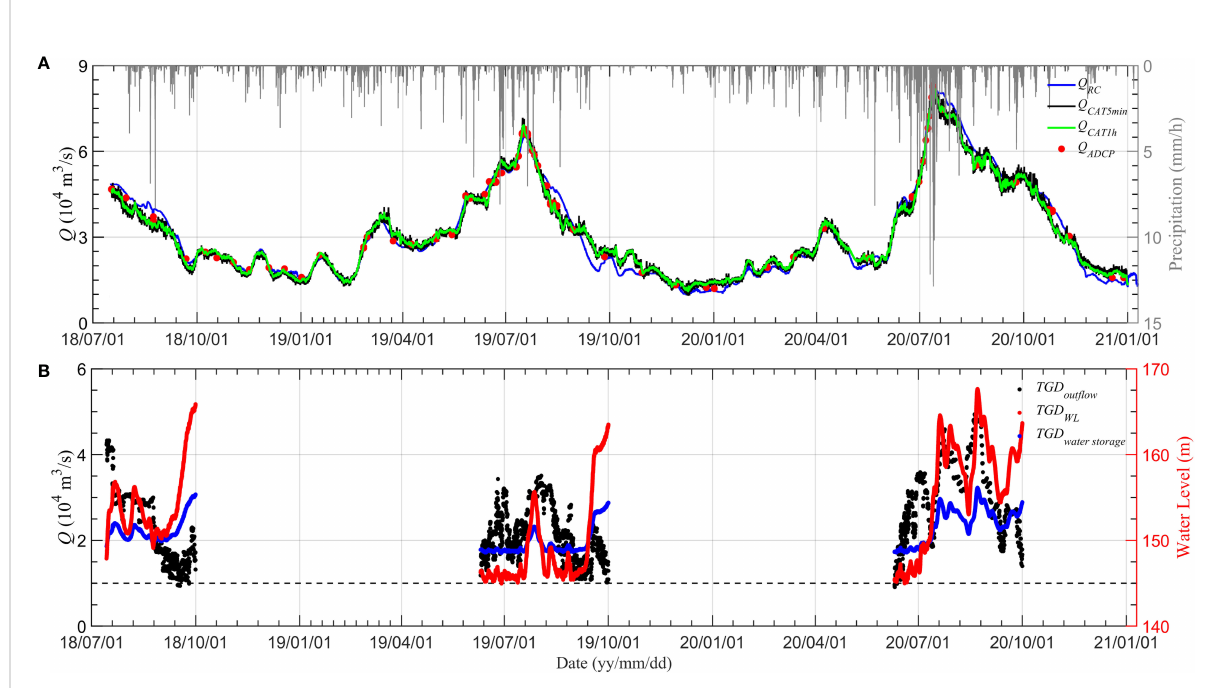
FIGURE 5 (A) Discharge time series during the observation period (July 2018 to January 2021) for different methods, RC (blue) and CAT. The black line represents the raw 5-min interval of CAT data and the green line represents the 1-h moving average. Red dots represent results obtained using the moving-boat ADCP. The gray bar shows hourly precipitation data near the Datong station obtained from ERA5 data; (B) TGD out fl ow, water storage, and water level time series during the observation period.